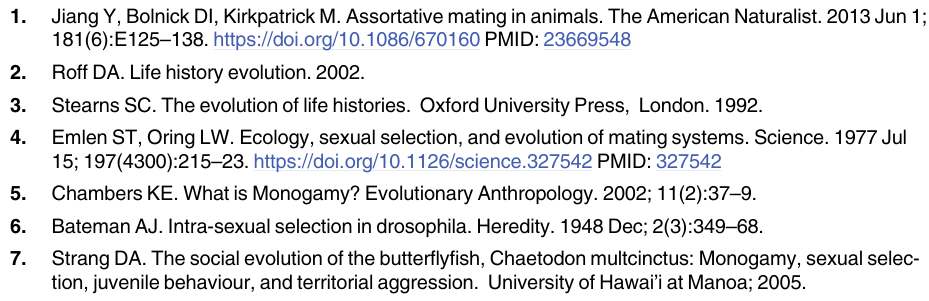
S3 Fig. Sagittal otoliths of Heniochus varius . Used for determining annual age increments. Top: Male, Age = 4; Bottom: Female, Age = 7. Red dots indicate growth increments. (TIF) S1 Data. LengthWeightAgeTL Hvarius . (CSV) S2 Data. HumpHornTL Hvarius . (CSV) S3 Data. HumpHornPairs Hvarius .